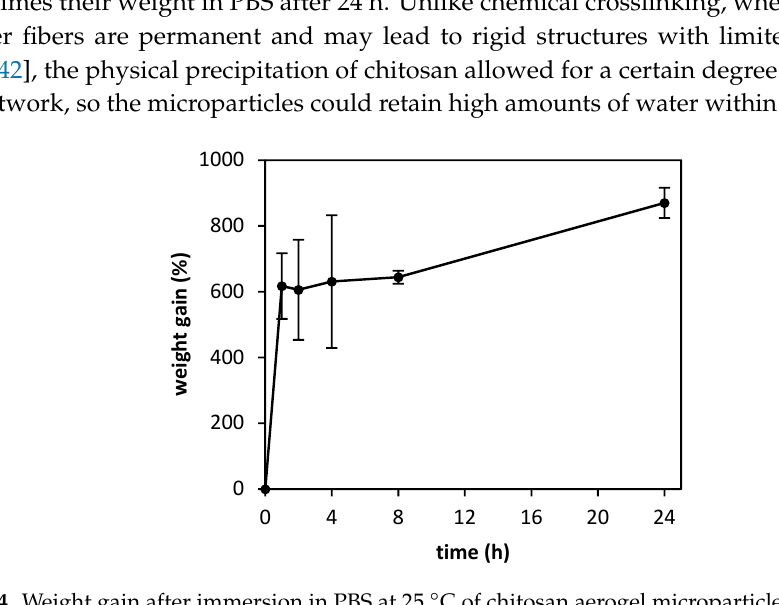
Figure 4. Weight gain after immersion in PBS at 25 °C of chitosan aerogel microparticles processed by a nozzle diameter of 500 μ m, a cutting disc velocity of 4000 rpm, and gelified in NH 3 /EtOH solution.